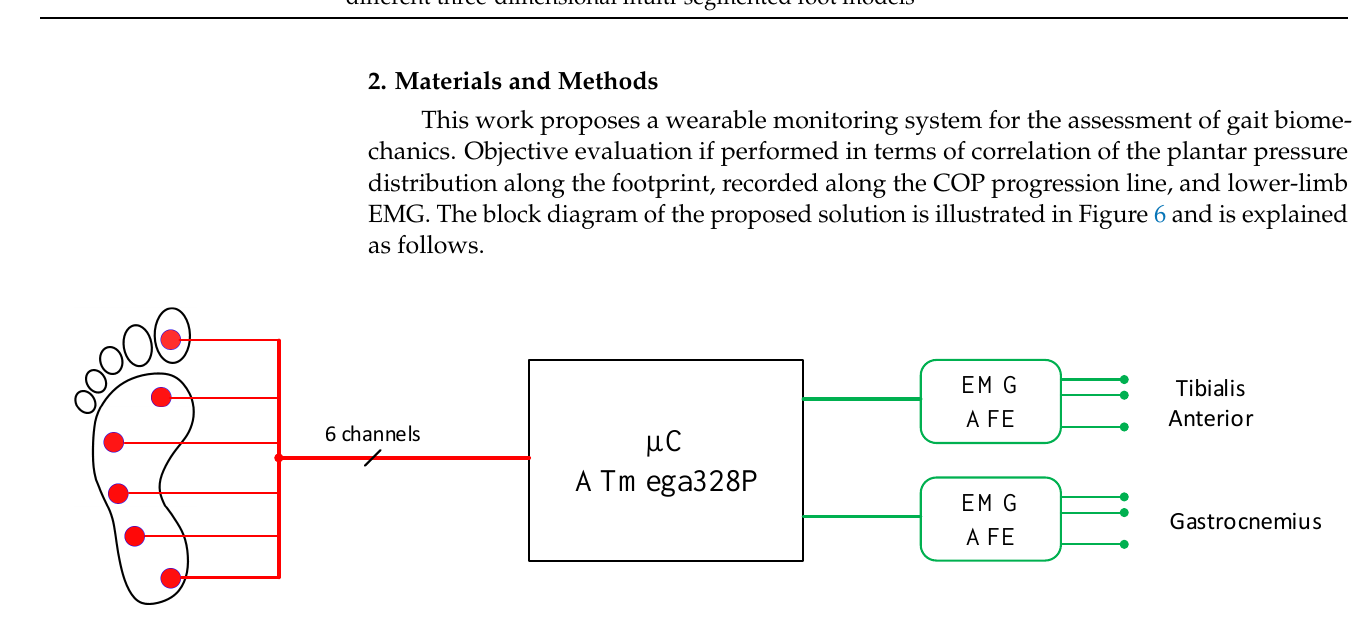
Figure 6. Block diagram of the proposed wearable foot biomechanics monitoring system.